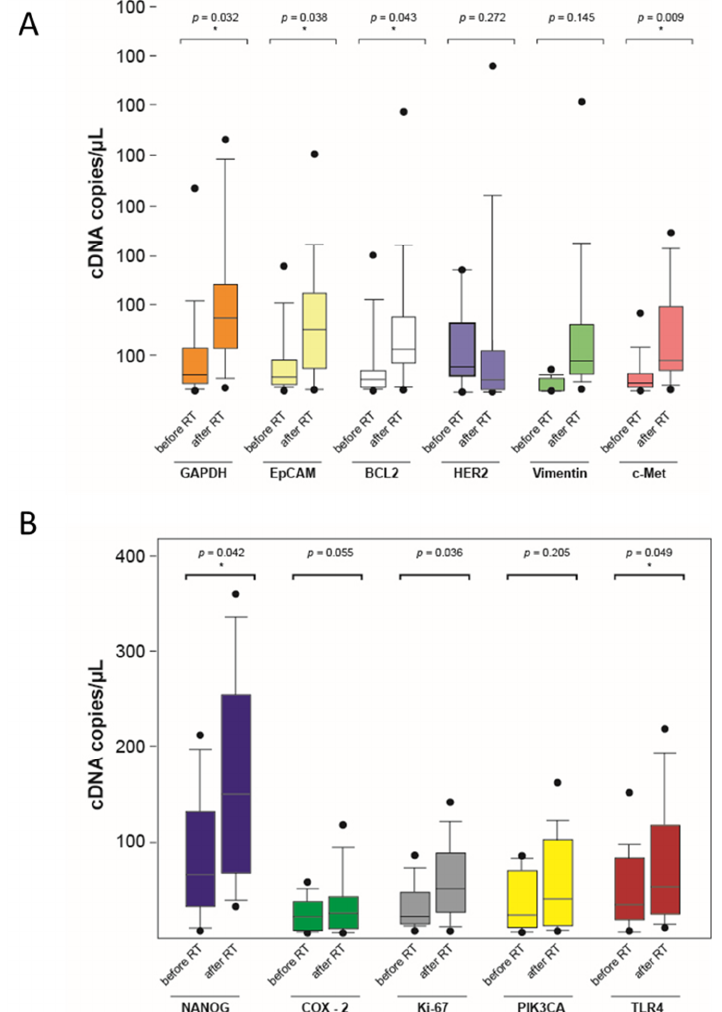
Figure 5. Mean mRNA copy number before and after the end of radiotherapy in a boxplot diagram (* significant, p < 0.05) ( A , B